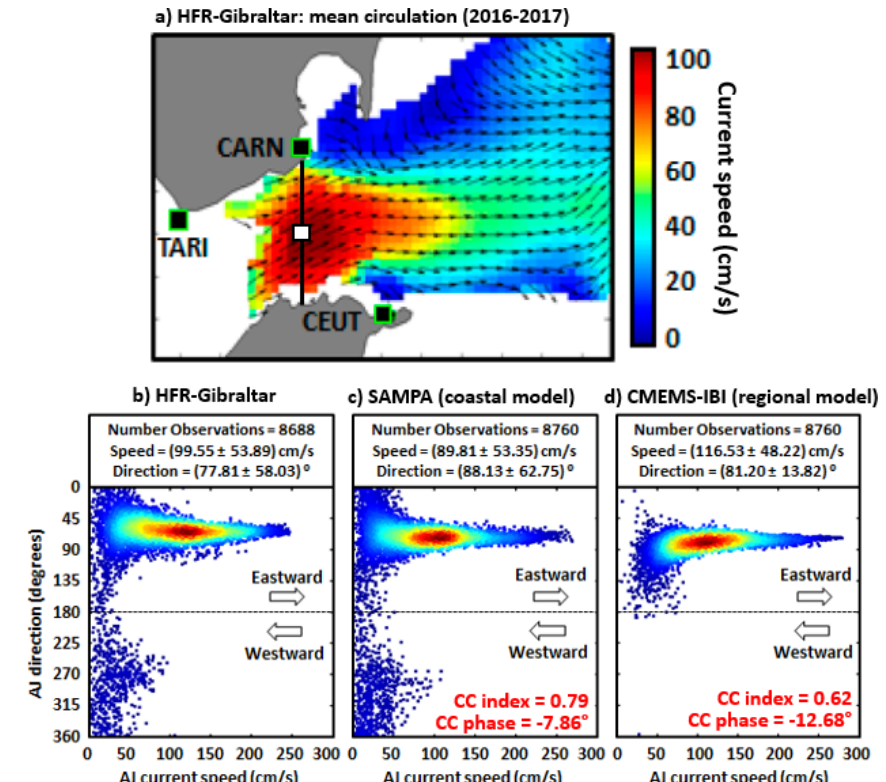
Figure 4. (a) HFR-derived mean surface circulation pattern in the Strait of Gibraltar for 2016–2017: classical Atlantic Jet inflow into the Mediterranean, with strong surface currents flowing to the NE. Solid black squares represent radar sites. The black line and the related white square indicate the selected transect and its midpoint, respectively. (b–d) Quantitative validation at the selected grid point (5.43 ◦ W, 35.99 ◦ N) within the Strait of Gibraltar: annual (2017) scatter plot of hourly current speed versus direction (angle measured clockwise from the north); estimations provided by HFR-Gibraltar (b) , SAMPA high-resolution coastal model (c) and IBI-MFC (d) , a regional model into which SAMPA is nested. Mean and standard deviation values of both AJ speed and direction are gathered in black boxes. Magnitudes of the complex correlation (i.e., CC index) and phase between HFR and model-predicted currents are provided in red font. Adapted from Lorente et al.